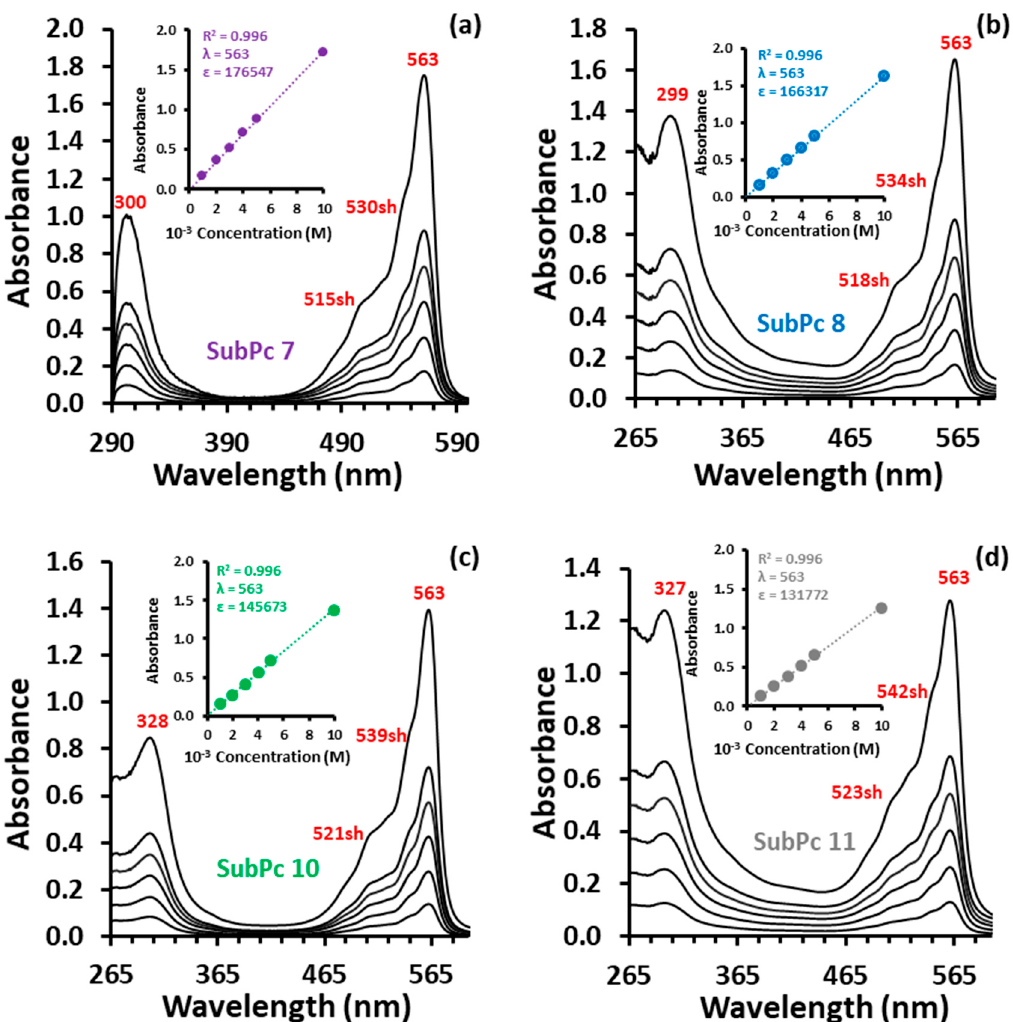
Figure 2. ( a )–( d ) The UV / vis spectra of SubPc ( 7 , 8 , 10 and 11 ) at concentrations 0.01, 0.02, 0.03, 0.04, 0.05 and 0.10 ( × 10 − 3 M), obtained with a 1 cm pathlength cuvette with tetrahydrofuran (THF) as solvent. UV / vis spectra of SubPc 9 can be found in reference [24]. Insert: The Beer-Lambert correlation between the absorbance A and concentration of FcCO 2 BSubPc(H) 12 , 7 ( ε = 176547 dm 3 mol − 1 cm − 1 );